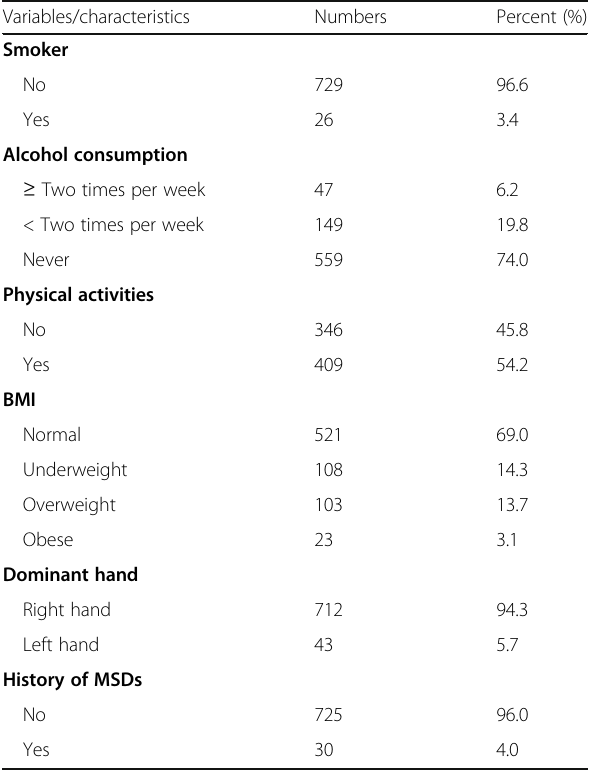
Table 2 Behavioral characteristics of bank workers in